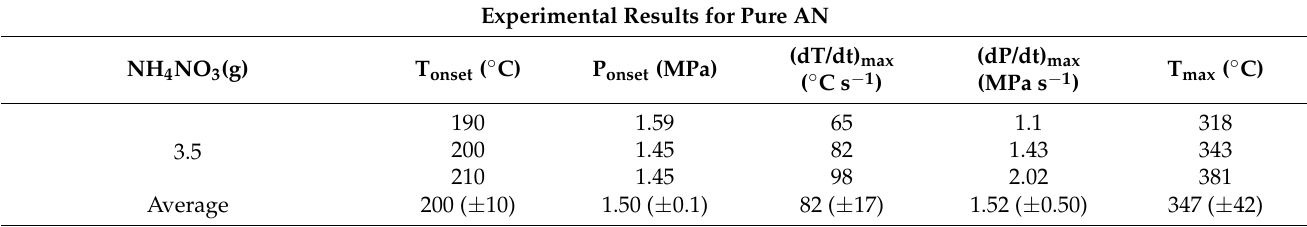
Table 6. Effect of Na 2 SO 4 and KCl on AN parameters. Reprinted with the permission of Elsevier from [35,36]. Experimental Results for Pure AN